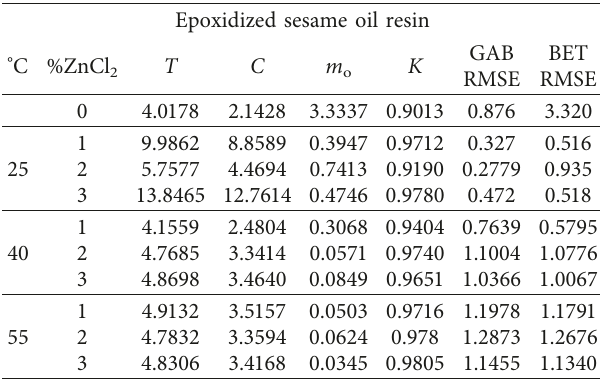
Figure 2: Adsorption of millet flour at 0, 1, 2, and 3% zinc chloride at 25 ° C. Table 1: GAB and BETparameters for moisture sorption isotherms for millet flour/epoxidized sesame and cottonseed oil resins ( m o g/ 100g water dry